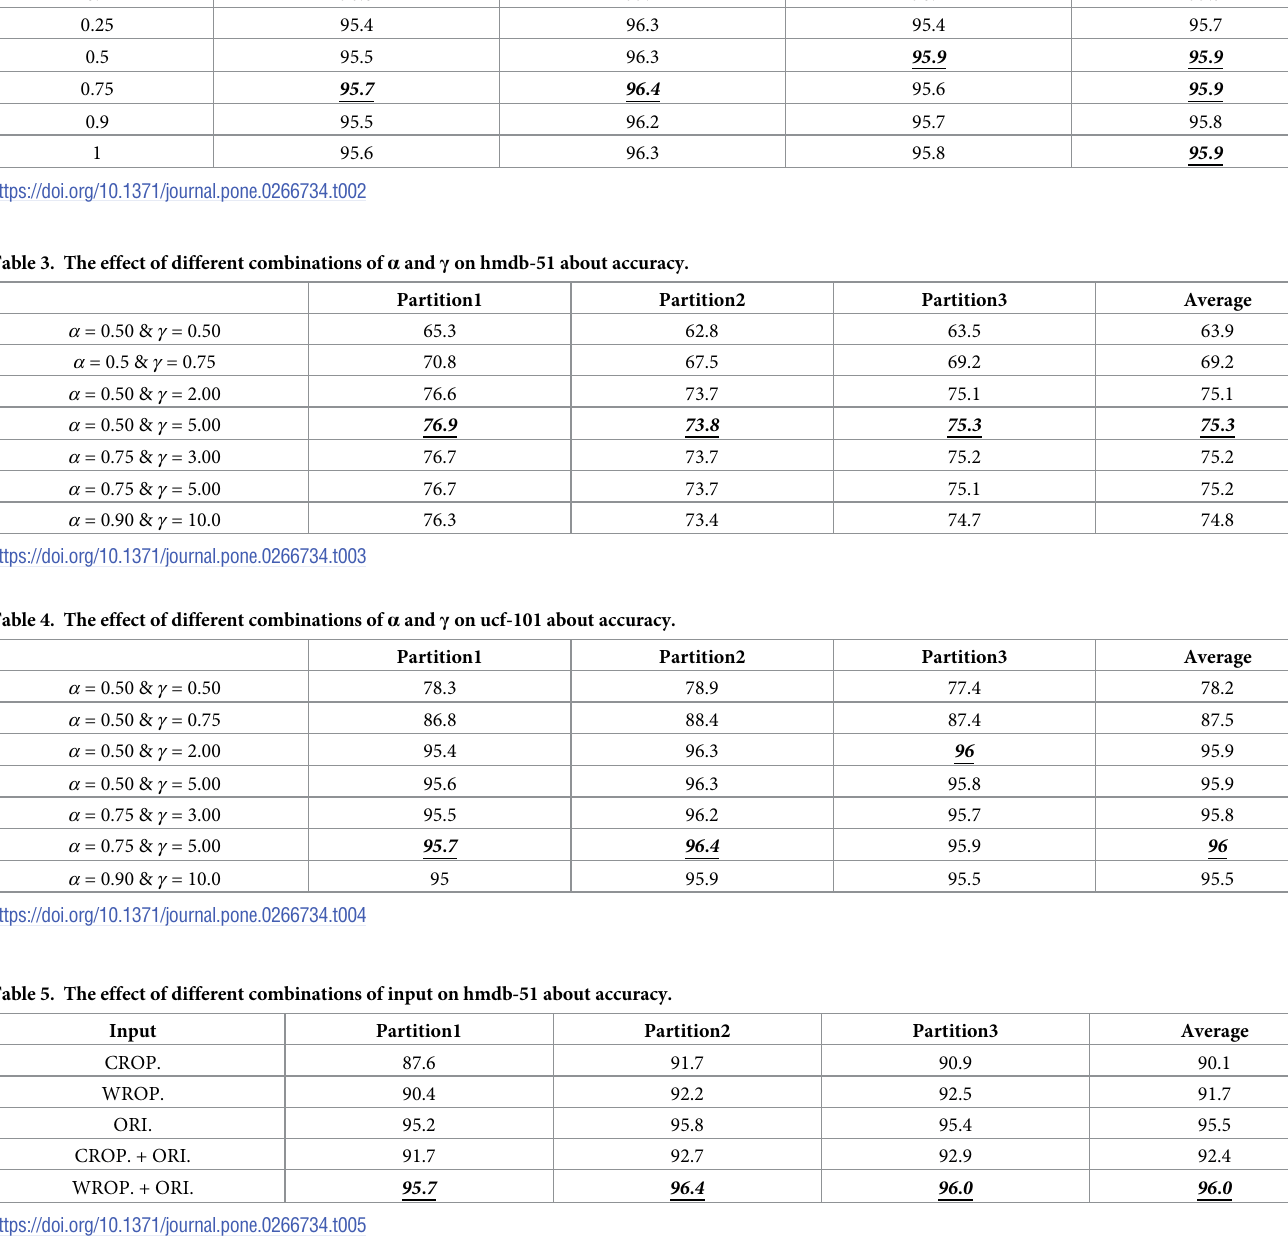
Table 6. The effect of different combinations of input ucf-101 about accuracy. Input Partition1 Partition2 Partition3 CROP. WROP. ORI. CROP. + ORI. WROP. +